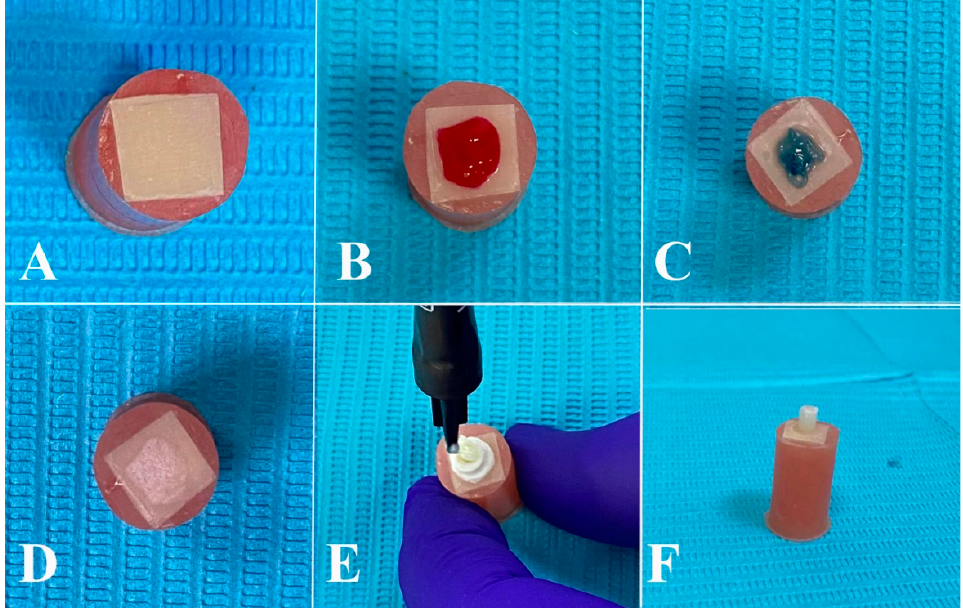
Figure 1. Steps of sample preparation: ( A )—ZLS block was polished, ( B )—HF acid application, ( C )—37% phosphoric acid application, ( D )—adhesive applied after washing in US and dryness, ( E )—resin cement poured in the mold, ( F )—final sample.